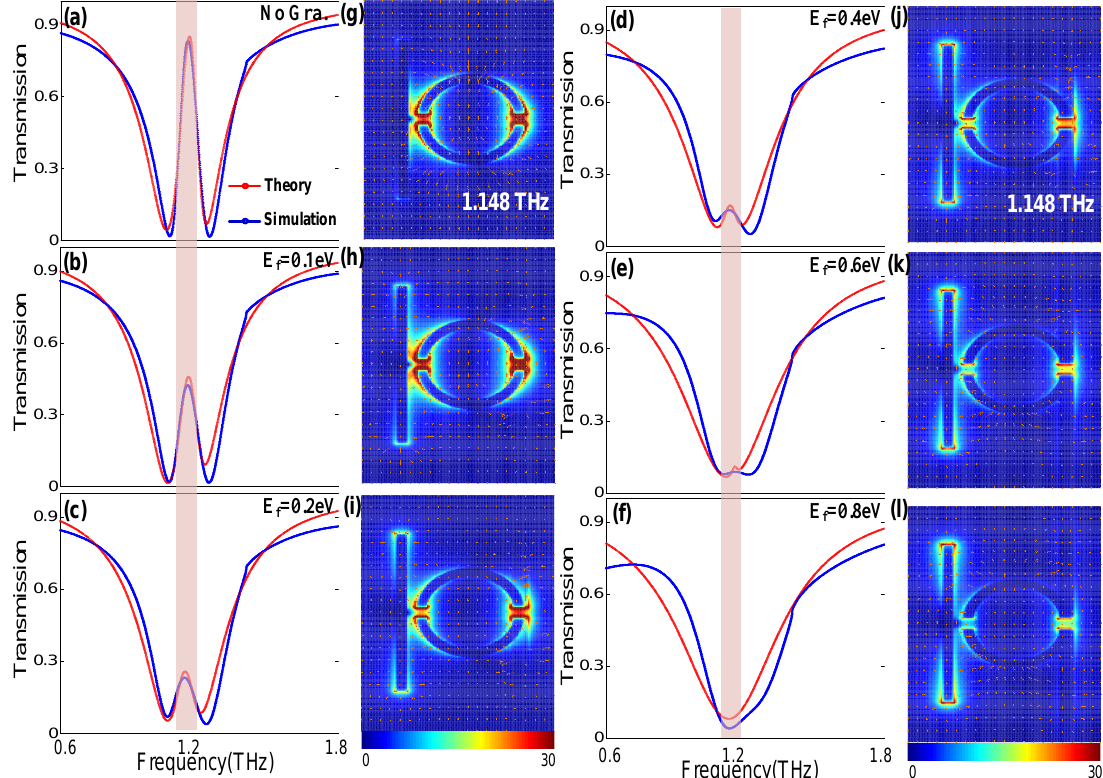
Figure 5. ( a – f ) Transmission profile of the hybrid metamaterials and the corresponding analytical fitted curves with increasing Fermi level of graphene. ( g – l ) Corresponding transmitted electric field distributions at 1.14 THz resonant frequency; the polarization vector is indicated by arrows.